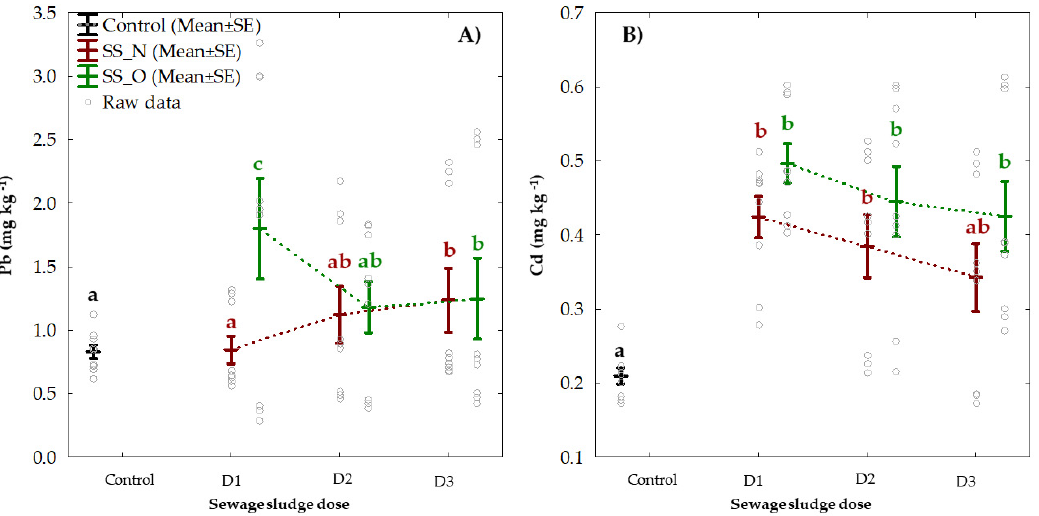
Figure 5. ( A – B ). Content of toxic heavy metals (Pb, Cd) in the aboveground biomass of maize depending on the type and dose of sewage sludge (mean values from experiment series). Mean values (n = 9) ± standard error. Identical superscripts denote no significant ( p > 0.05) differences between the experimental variants according to the post hoc Tukey HSD test. Explanation: SS_N—non-ozo- nated sewage sludge; SS_O—ozonated sewage sludge; D1, D2, D3—dose of sewage sludge—3, 6, 9 Mg ha − 1 , respectively.